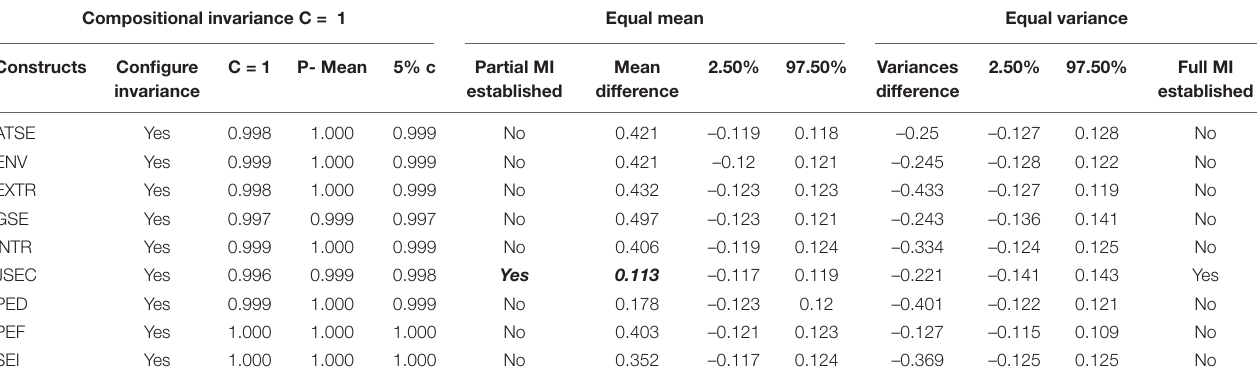
TABLE 10 | Compositional invariance of China vs. Pakistan. Compositional invariance C = 1 Equal mean Equal variance